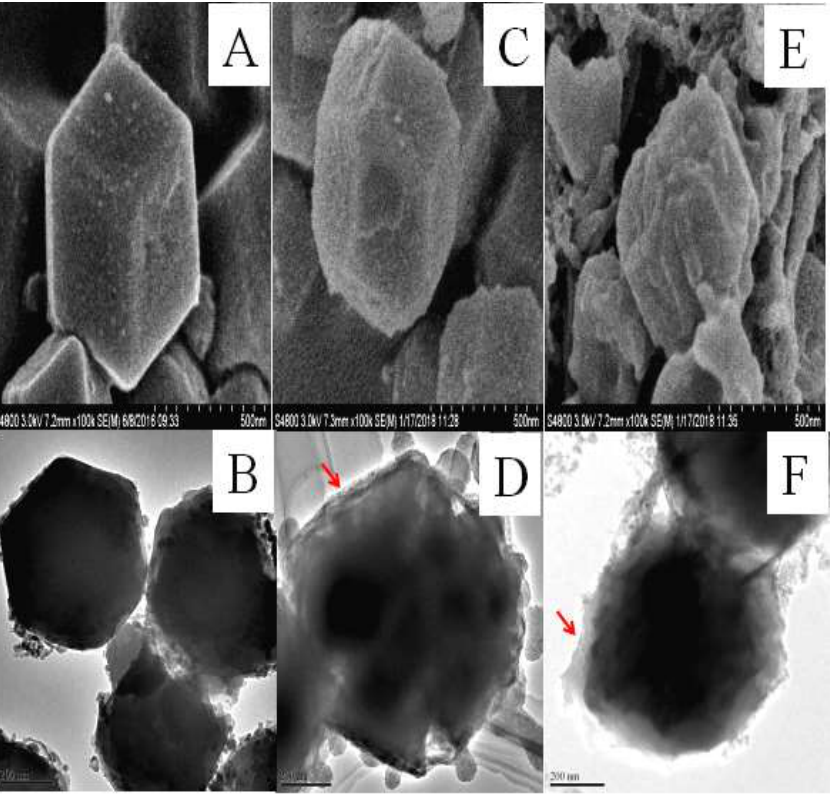
Figure 2 SEM images and TEM images of CAT/ZIF-8 ( A , B ), SiO 2 @CAT/ZIF-8 ( C , D ), and Fe 3+